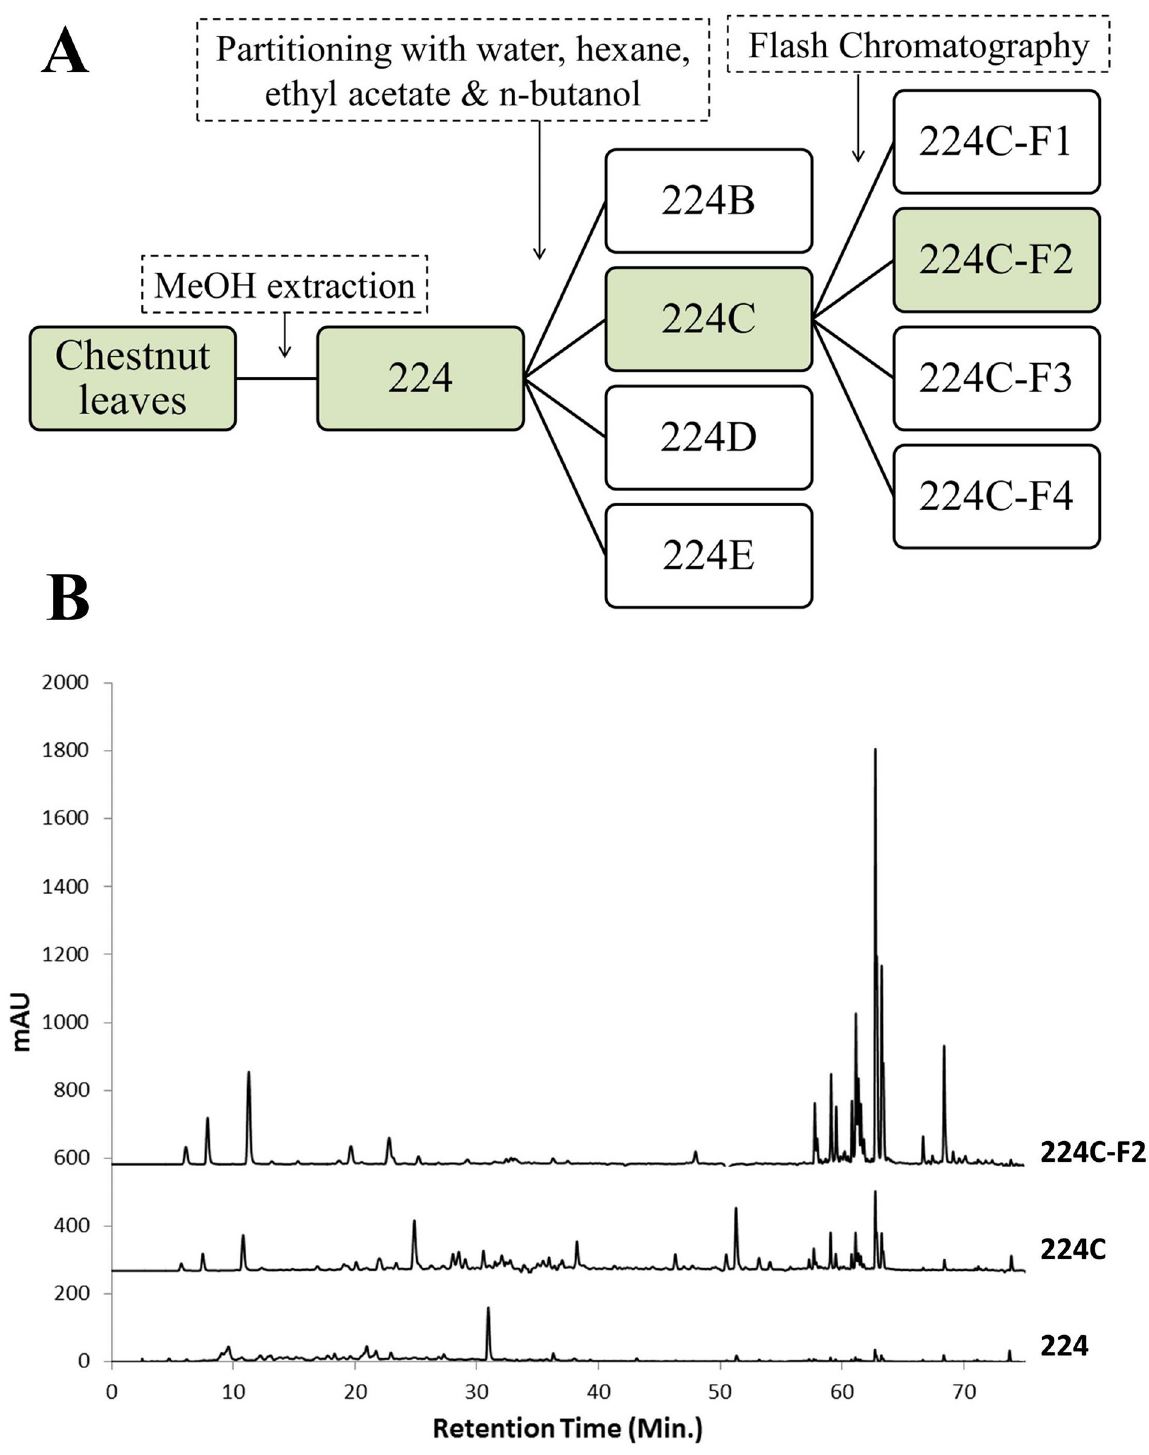
Fig 2. Isolation scheme. (A) The bioassay-guided fractionation scheme is illustrated, demonstrating the path from raw plant material to isolated, active natural products. ( B) The corresponding HPLC chromatogram for the most active fractions illustrates how fractionation functions to increase the relative levels of active